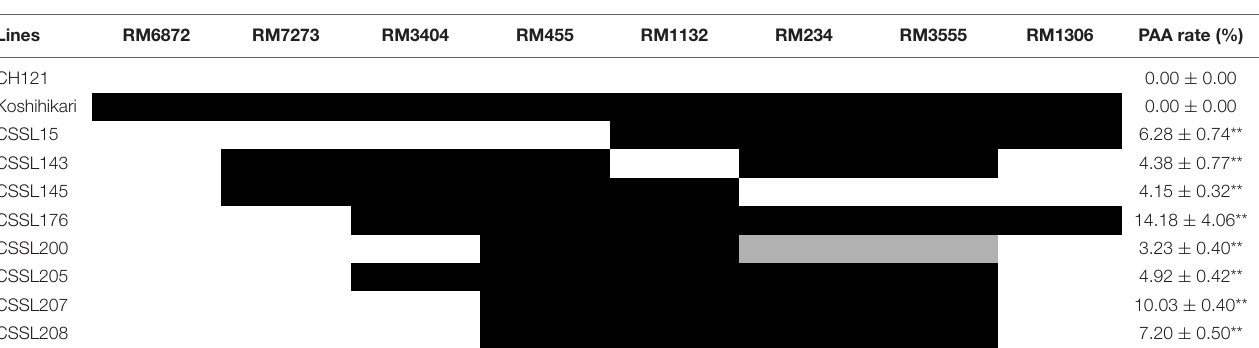
TABLE 4 | Graphical genotypes and aborted spikelets rate of 8